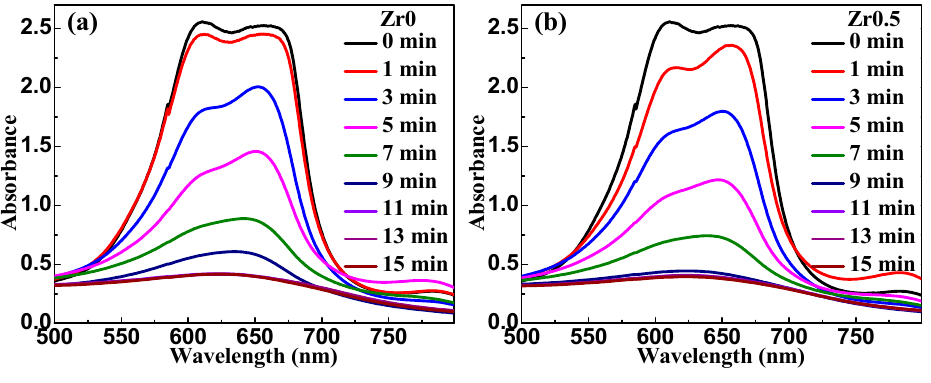
Figure 2. The transmission electron microscopy (TEM) images of the as-spun ( a ) Zr0, ( b ) Zr0.5 and ( c ) Zr1 ribbons, the SAED (Selected area electron diffraction)patterns of the as-spun ( d ) Zr0, ( e ) Zr0.5 and ( f ) Zr1